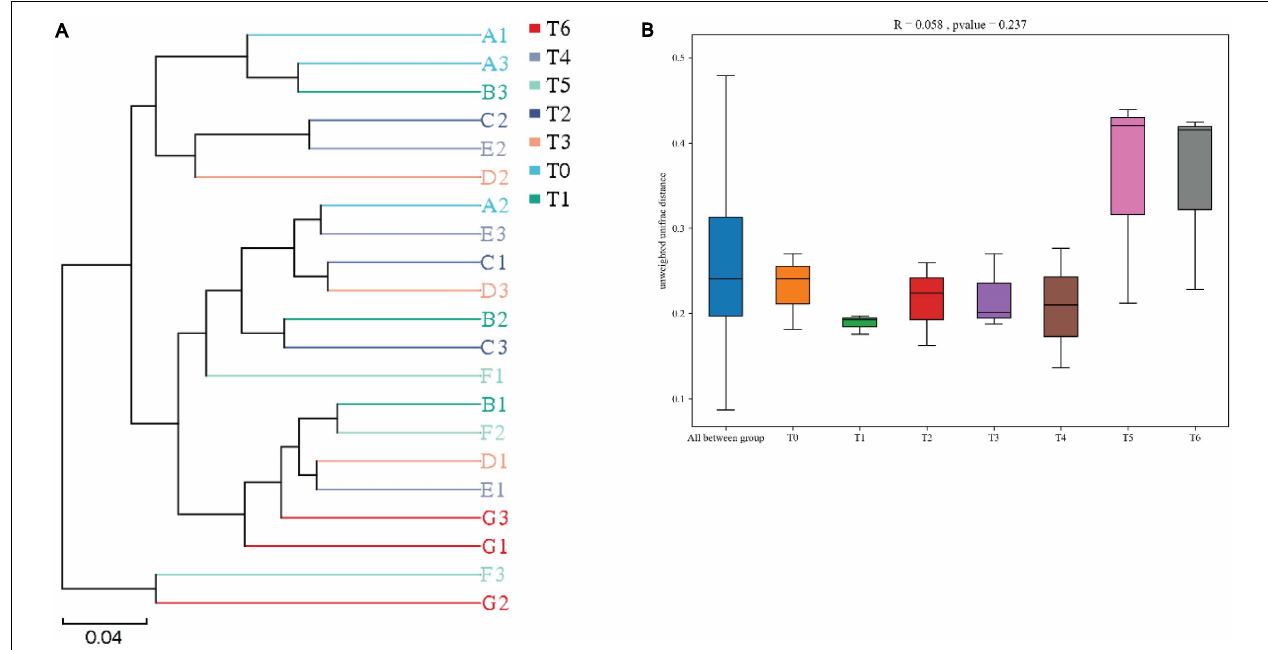
FIGURE 4 | Beta diversity of intestinal microbiota based on binary_jaccard distance of grouper E. coioides at day 56. (A) UPGMA-clustering trees at genus level. (B) Beta ( β )-diversity boxplots based on phylum. A1, A2, and A3 refer to triplicates of group T0; B1, B2, and B3 refer to triplicates of group T1; C1, C2, and C3 refer to triplicates of group T2; D1, D2, and D3 refer to triplicates of group T3; E1, E2, and E3 refer to triplicates of group T4; F1, F2, and F3 refer to triplicates of group T5; G1, G2, and G3 refer to triplicates of group